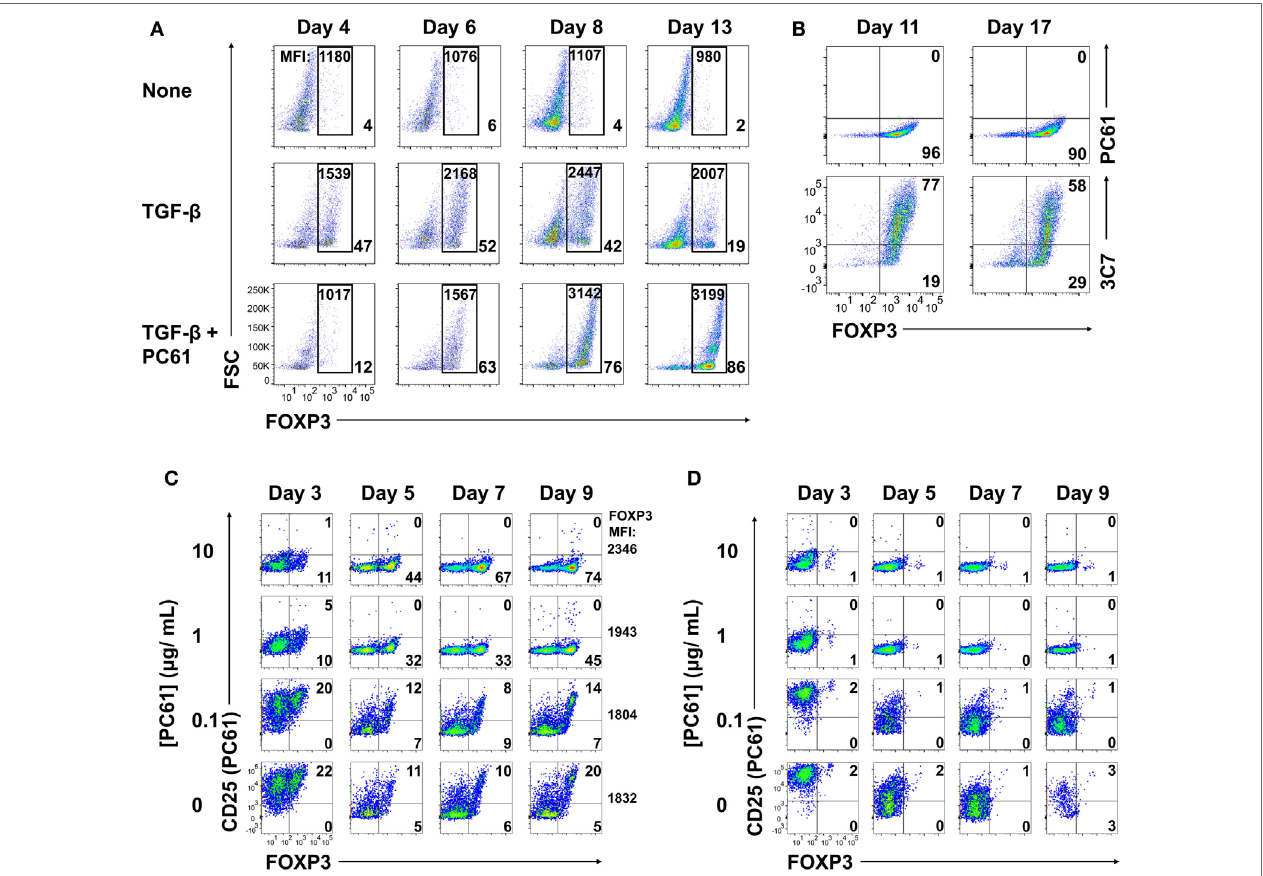
FigUre 2 | The anti-CD25 PC61 monoclonal antibody (mAb) selectively favored regulatory T cell (Treg) dominance in mixed Treg/conventional T cell cultures. (a–D) 2D2-FIG splenocytes were activated at a density of 2 × 10 6 cells/ml in cRPMI with MOG35-55 (1 µM) in the presence or absence of TGF- β (10 nM) and/or designated concentrations of PC61 (10 µg/ml; 65 nM, unless designated otherwise). Antigen and TGF- β were present only in the first activation culture and not thereafter. After 3–4 days of activation, cells were passaged at a density of 10 6 cells/ml in media containing rat IL-2 with or without PC61. Cultures initiated with PC61 were continued with PC61 during passage into the same conditions every 2–4 days. (a) Cells were analyzed on days 4, 6, 8, and 13 post-activation for FOXP3 expression by gating on V β 11 + cells. The percentage of FOXP3 + Tregs compared to total V β 11 + cells is indicated in the bottom right of each dotplot. The geometric mean fluorescence intensity of GFP expression is indicated at the top of each gate. (B) The initial T cell activation culture did not include PC61, and T cells were then passaged every 3–4 days in rat IL-2 and 10 µg/ml PC61. V β 11-gated T cells were analyzed on day 11 and 17 for expression of CD25 by PE-conjugated 3C7 or APC-conjugated PC61 anti-CD25 mAb. (c,D) The initial activation culture with (c) or without (D) TGF- β included concentrations of PC61 (10, 1, 0.1 µg/ml, or none) that were maintained throughout the course of the experiment. On days 3, 5, 7, and 9, V β 11 + cells were analyzed for FOXP3 expression and for binding of an APC-conjugated anti-CD25 PC61 mAb. These data are representative of three independent